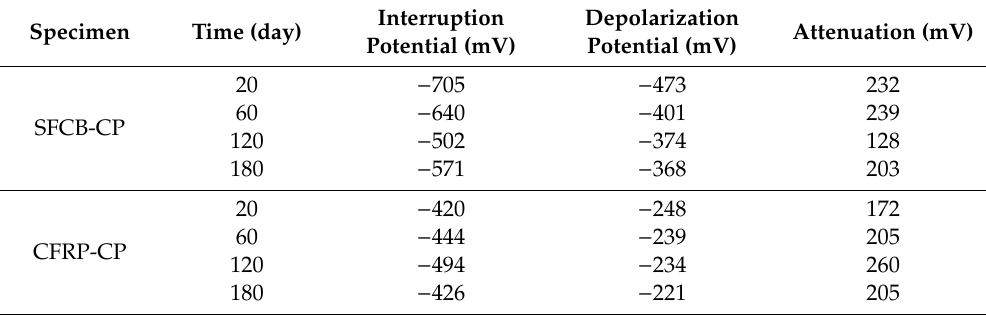
Figure 9. Self-corrosion potential for the steel bar in the dry – wet cycles experiment. Table 4. Variation of the interruption potential for the concrete beams.